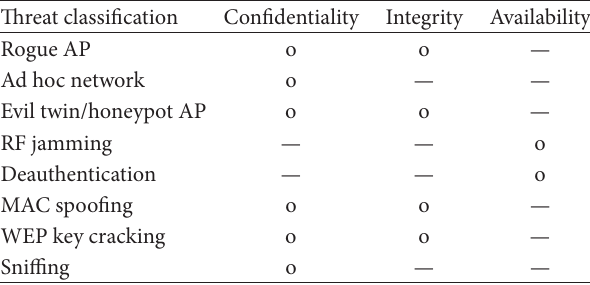
Table 2: Classification of wireless security threats during business work using mobile